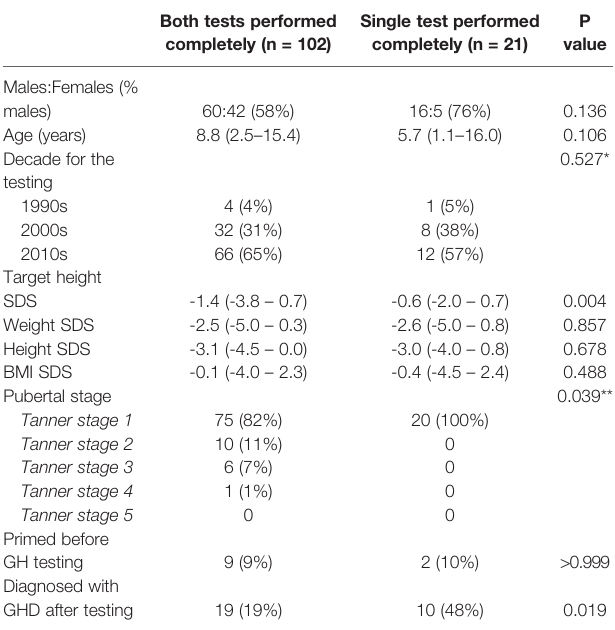
TABLE 1 | Clinical characteristics of short children evaluated for possible growth hormone de fi ciency (GHD) divided by number of GH tests performed together with data on whether GHD was diagnosed after testing.